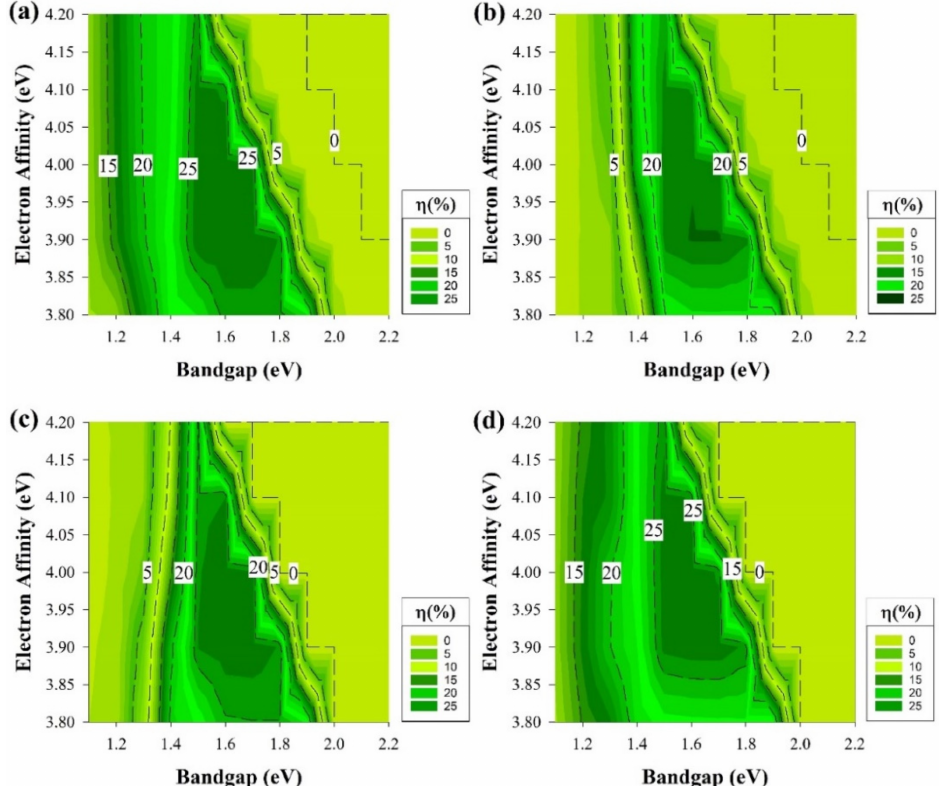
Figure 7. The efficiency of four proposed structures as a function of Eg and χ for all passivating and doped layers, including defects at the 0.2 eV level above the E V . ( a ) Contour graphs of the n-i-p structure with p-type wafer base. ( b ) Contour graphs of the n-i-p structure with n-type wafer base. ( c ) Contour graphs of the p-i-n structure with the p-type wafer. ( d ) Contour graphs of the p-i-n structure with n-type wafer